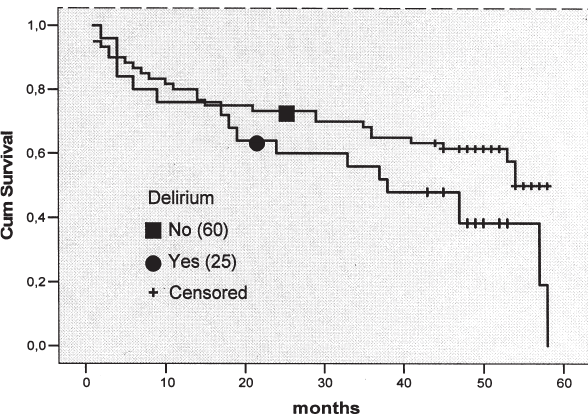
Table 3 - Cox regression model 1 for mortality